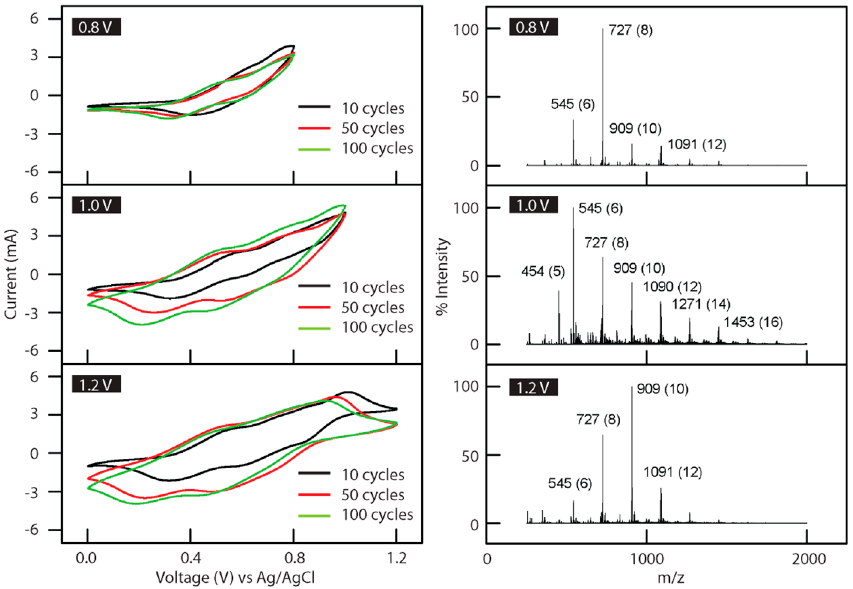
Figure 3. Electropolymerization of aniline tetramer in solution through repeated CV cycling with varying potential windows and the change in aniline oligomer distribution shown by Matrix-Assisted Laser Desorption Ionization Time-of-Flight (MALDI TOF) spectrometry.